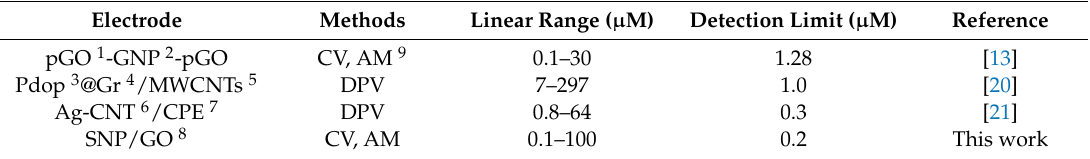
Figure 4. ( a ) Amperometric i-t dopamine response with the addition of various dopamine concentrations; ( b ) linear curve of the peak current values and different dopamine concentrations ( n = 3). Table 1. Comparison of some electrochemical characteristics of different graphene-based or SNP-based electrodes for the detection of dopamine.